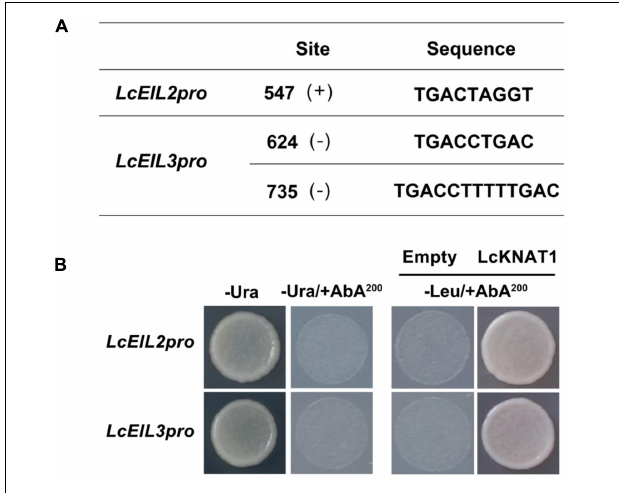
FIGURE 2 | Binding of LcKNAT1 to the promoters of LcEIL2 and LcEIL3 by Yeast one-hybrid (Y1H) assay. (A) The core TGAC cis -elements were responsible for KNOX protein binding in the promoters of LcEIL2 and LcEIL3. (B) The Y1H analysis of LcKNAT1 binding to LcEIL2/3 promoters. Left: No basal activities of LcEIL2 or LcEIL3 promoter were detected in yeast grown on SD medium lacking Ura in the presence of aureobasidin A (AbA). Right: Yeast growth assay after the Y1H reporter strains were co-transformed with LcKNAT1 effector. The interaction was evaluated based on the growth conditions of transformed yeast on SD medium lacking Leu in the presence of AbA.